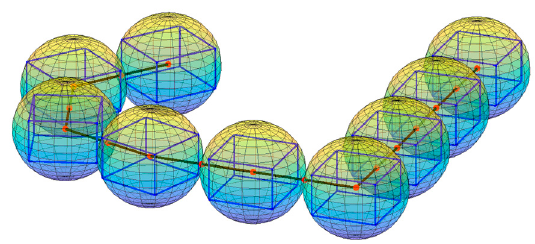
Figure 5. Spherical envelope of SMSRS with nine modules.